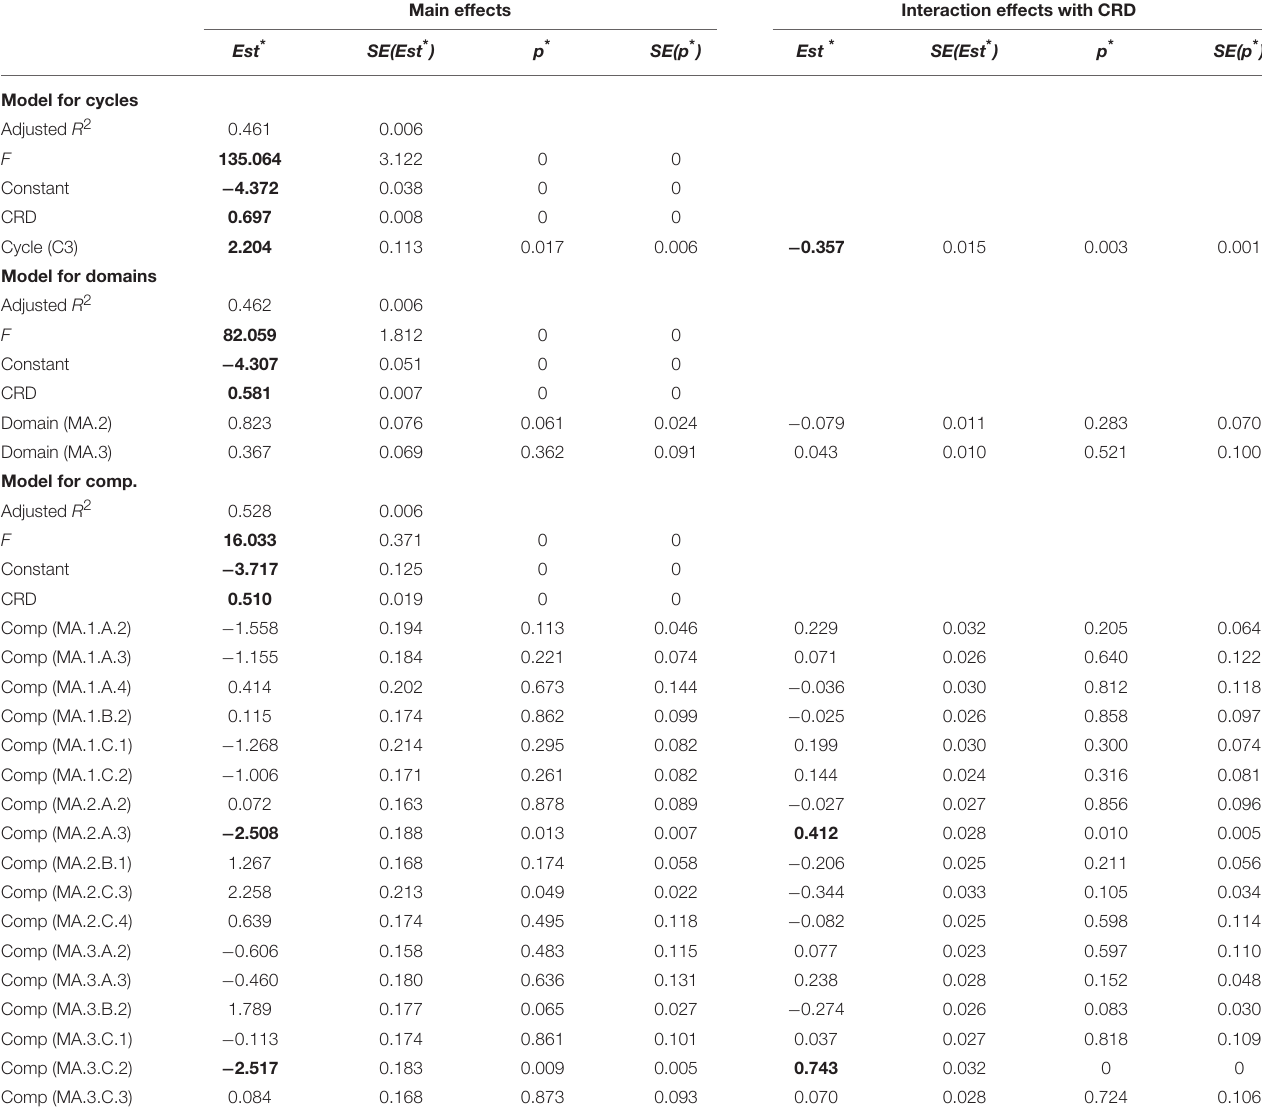
TABLE 7 | Results from multiple linear regression analyses for predicting empirical item difficulty by CRD and by the curriculum levels cycle, domain, and